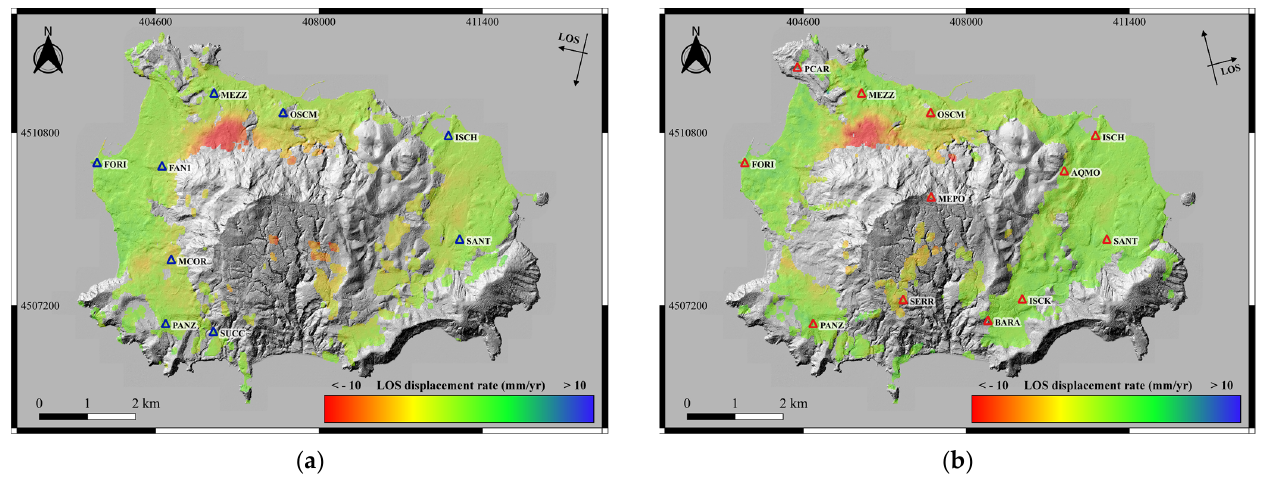
Figure 3. Descending ( a ) and ascending ( b ) LOS displacement maps computed by using Envisat data.